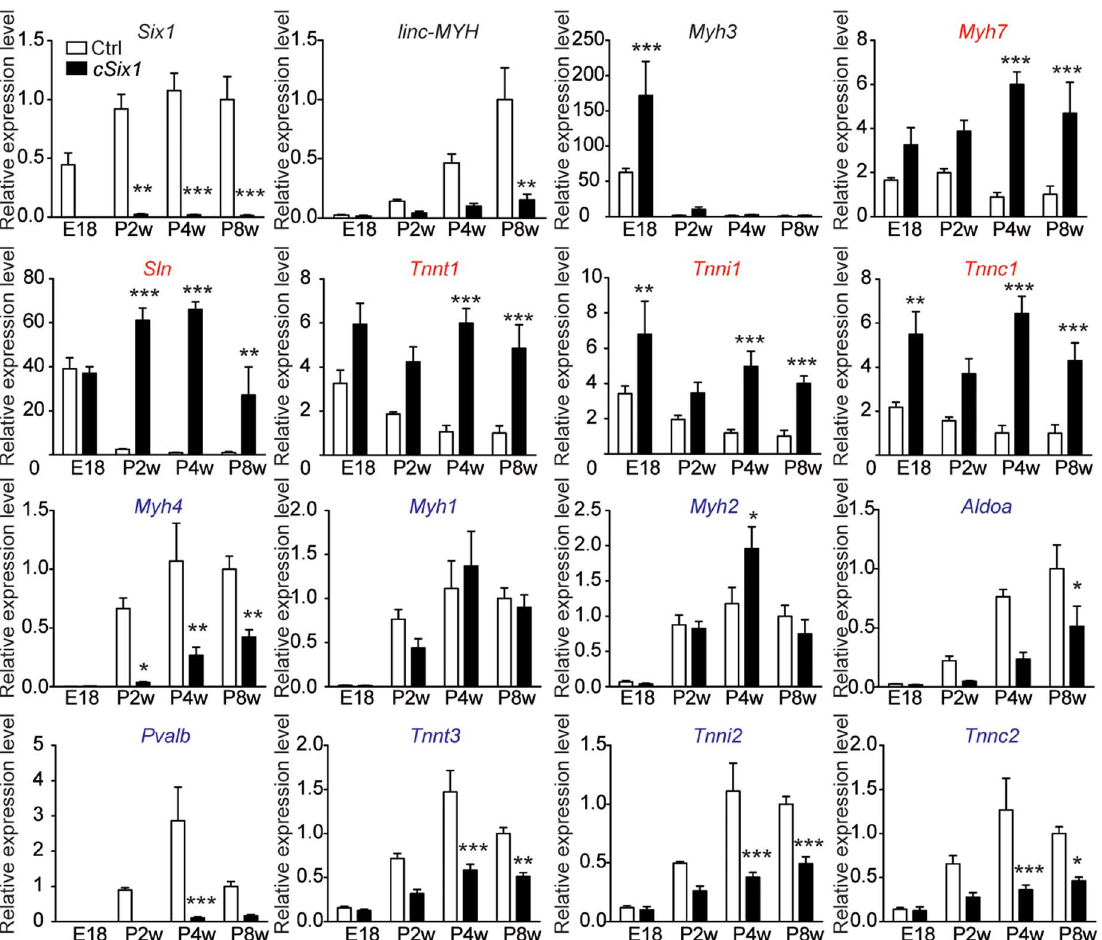
Figure 2. The expression of fast-type genes and linc-MYH is impaired in cSix1KO mice during postnatal development. mRNA expression level of Six1 , linc-MYH , Myh3 , slow-type genes (red) and fast-type genes (blue) in back muscles of cSix1 KO mice at E18.5, P2W, P4W and P8W, as determined by qPCR experiments, (n=3 to 6 for each point). *P , 0.05, **P , 0.01, ***P , 0.001.